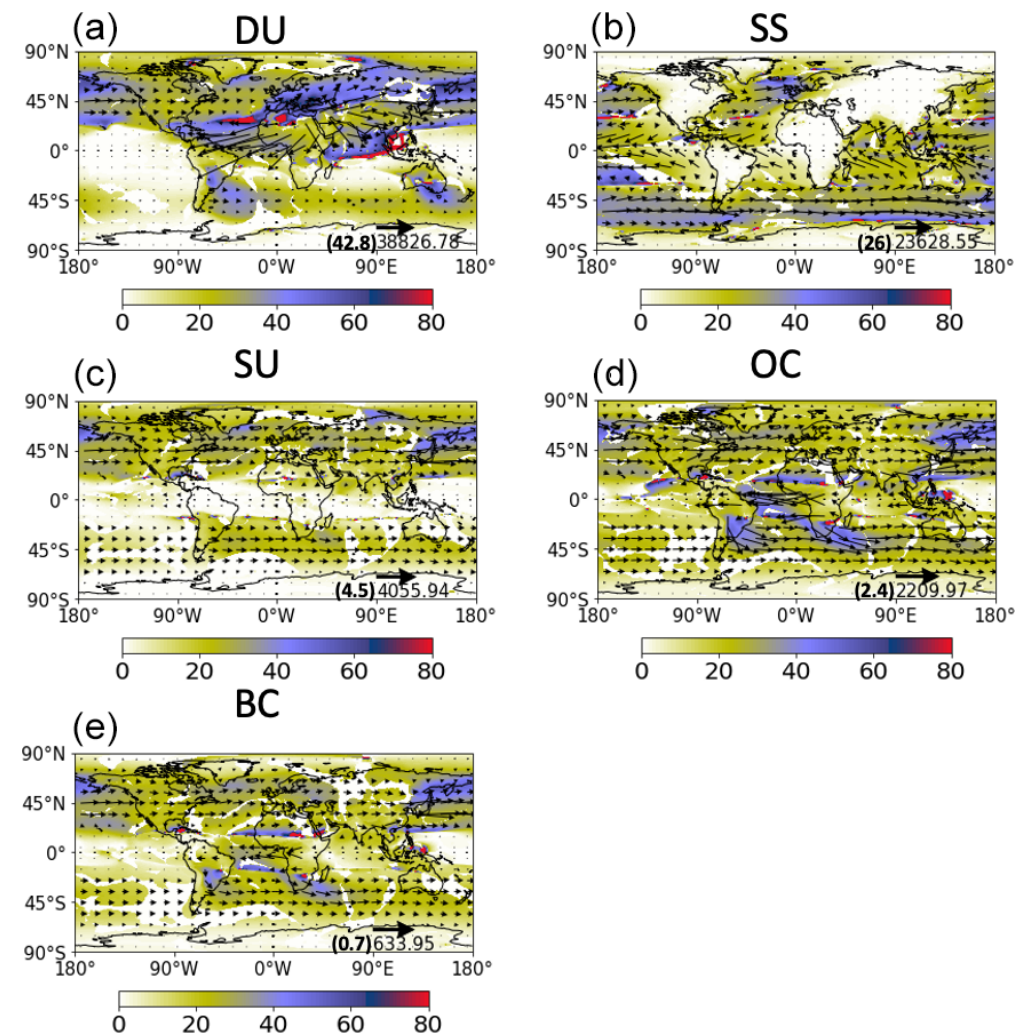
Figure 6. Fraction of annual total IAT transport (arrows; tonnes are shown in parentheses, followed by kgm − 1 ) accounted for by AARs (%; shading) of five different aerosol